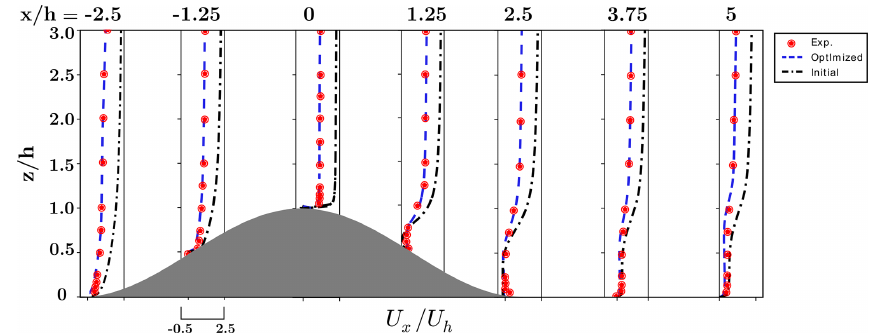
Figure 8. Normalized vertical profiles of longitudinal velocity component on the central plane of the hill. U h is the velocity at the hill height in the undisturbed region of the domain between inlet and